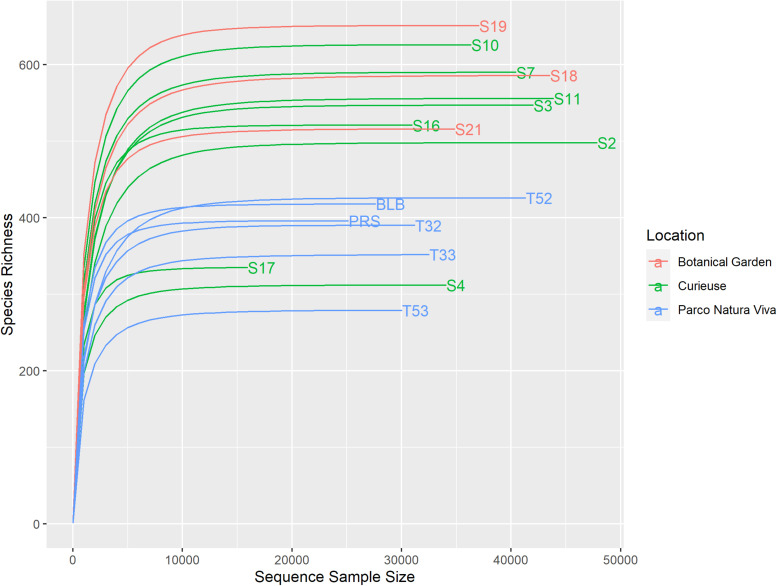
Rarefaction curves of the samples. Different colors have been used for the samples regarding the different conditions.